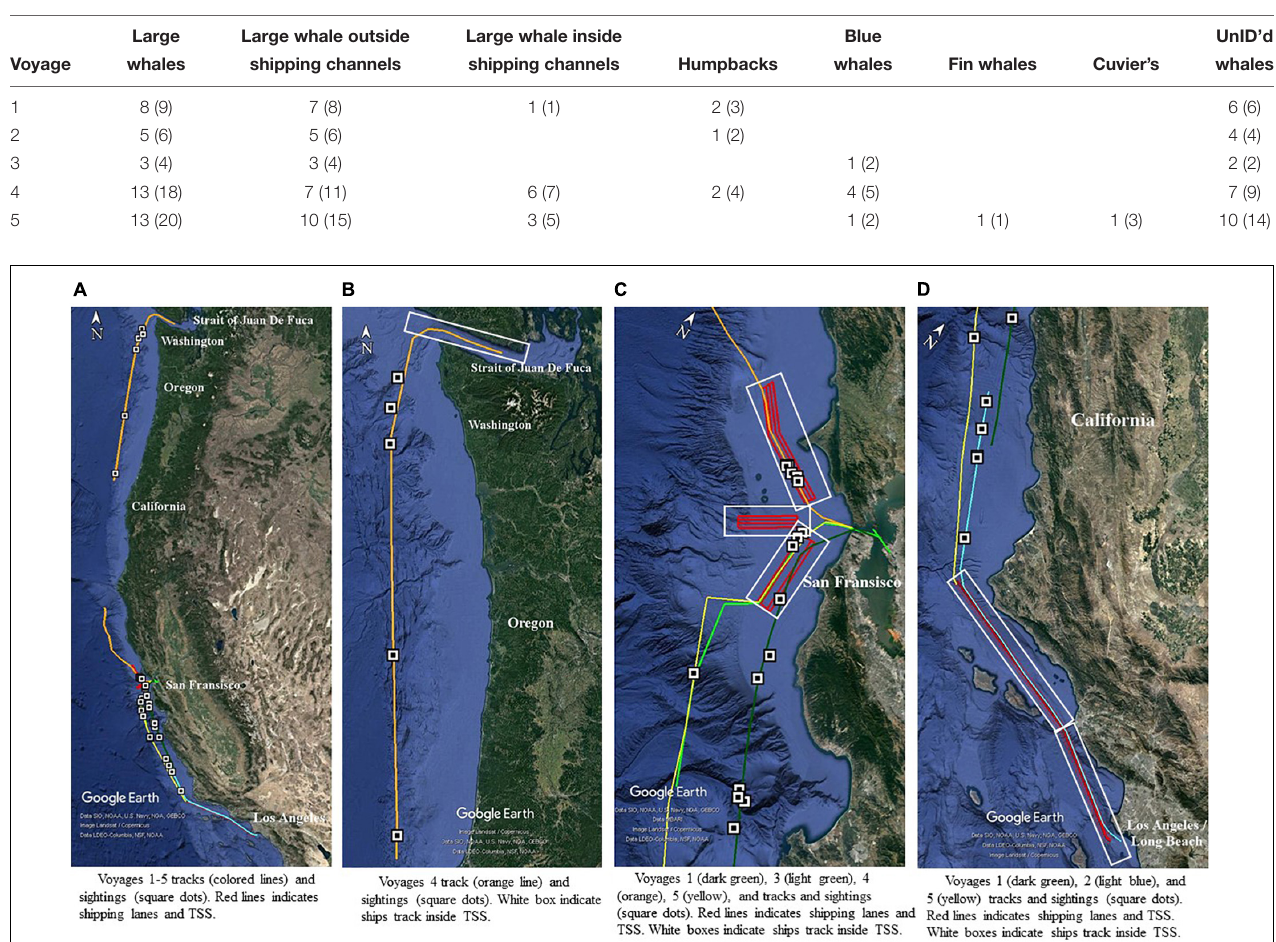
TABLE 3 | Numbers of sightings and individuals of large whales, inside and outside shipping